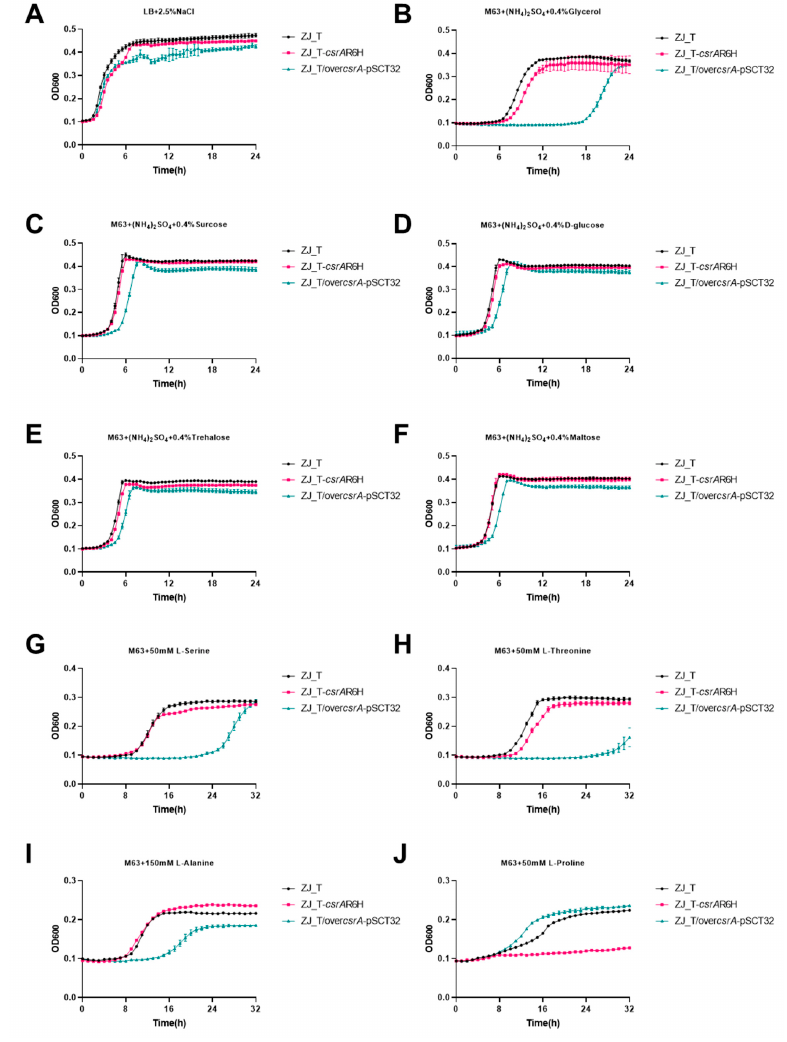
Figure 3. CsrA is extensively involved in carbon and nitrogen metabolism. Growth curves of the wild type, csrA point mutation, and overexpression strains grown in LB + 2.5% NaCl rich medium ( A ), minimal medium M63 containing (NH 4 ) 2 SO 4 and 0.4% glycerol ( B ), M63 plus (NH 4 ) 2 SO 4 plus sucrose ( C ), M63 plus (NH 4 ) 2 SO 4 plus glucose ( D ), M63 plus (NH 4 ) 2 SO 4 plus trehalose ( E ), and M63 plus (NH 4 ) 2 SO 4 plus maltose ( F ) and in M63 which D-glucose and (NH 4 ) 2 SO 4 were left out and replaced by the amino acids L-Serine (50 mM) ( G ), L-Threonine (50 mM) ( H ), L-Alanine (150 mM) ( I ), and L- Proline (50 mM) ( J ) as the sole carbon and nitrogen sources. For growth curves, three biological replicates are shown as points with their average values connected by lines. Error bars indicate the standard error of mean (SEM). ZJ_T- csrA R6H exhibited wild-type growth in rich medium and M63 modified by 0.4% ( w / v ) of different carbohydrates, but overexpression strains showed longer lag phases for all carbon sources tested. When M63 was supplemented with serine, the lag phase of the other strains was prolonged compared with that of the wild type, but the total growth was the same in general. When M63 was supplemented with Threonine, the lag phase of the csrA mutant and overexpression strains was prolonged like in serine, but the csrA mutant displayed an increased growth yield. When M63 was supplemented with Alanine, csrA .R6H exhibited wild-type growth, but the duration of the lag phase and final biomass of the overexpression strain decreased obviously. In addition, When M63 was supplemented with Proline, the mutation of csrA affected the ability of V. alginolyticus to grow on